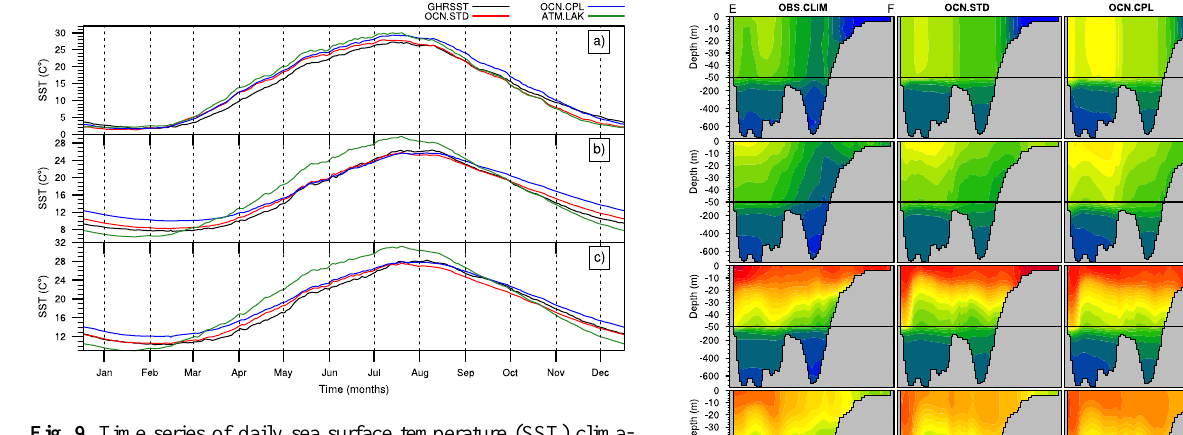
Fig. 9. Time series of daily sea surface temperature (SST) clima- tology of OCN.STD, OCN.CPL, ATM.LAK simulations and obser- vation (GHRSST) for the period 1999–2008. The order of plots is: (a) Northern Caspian Sea – NCAS, (b) Central Caspian Sea – CAS, and (c) Southern Caspian Sea – SCAS. The sub-regions are shown in Fig. 3b.